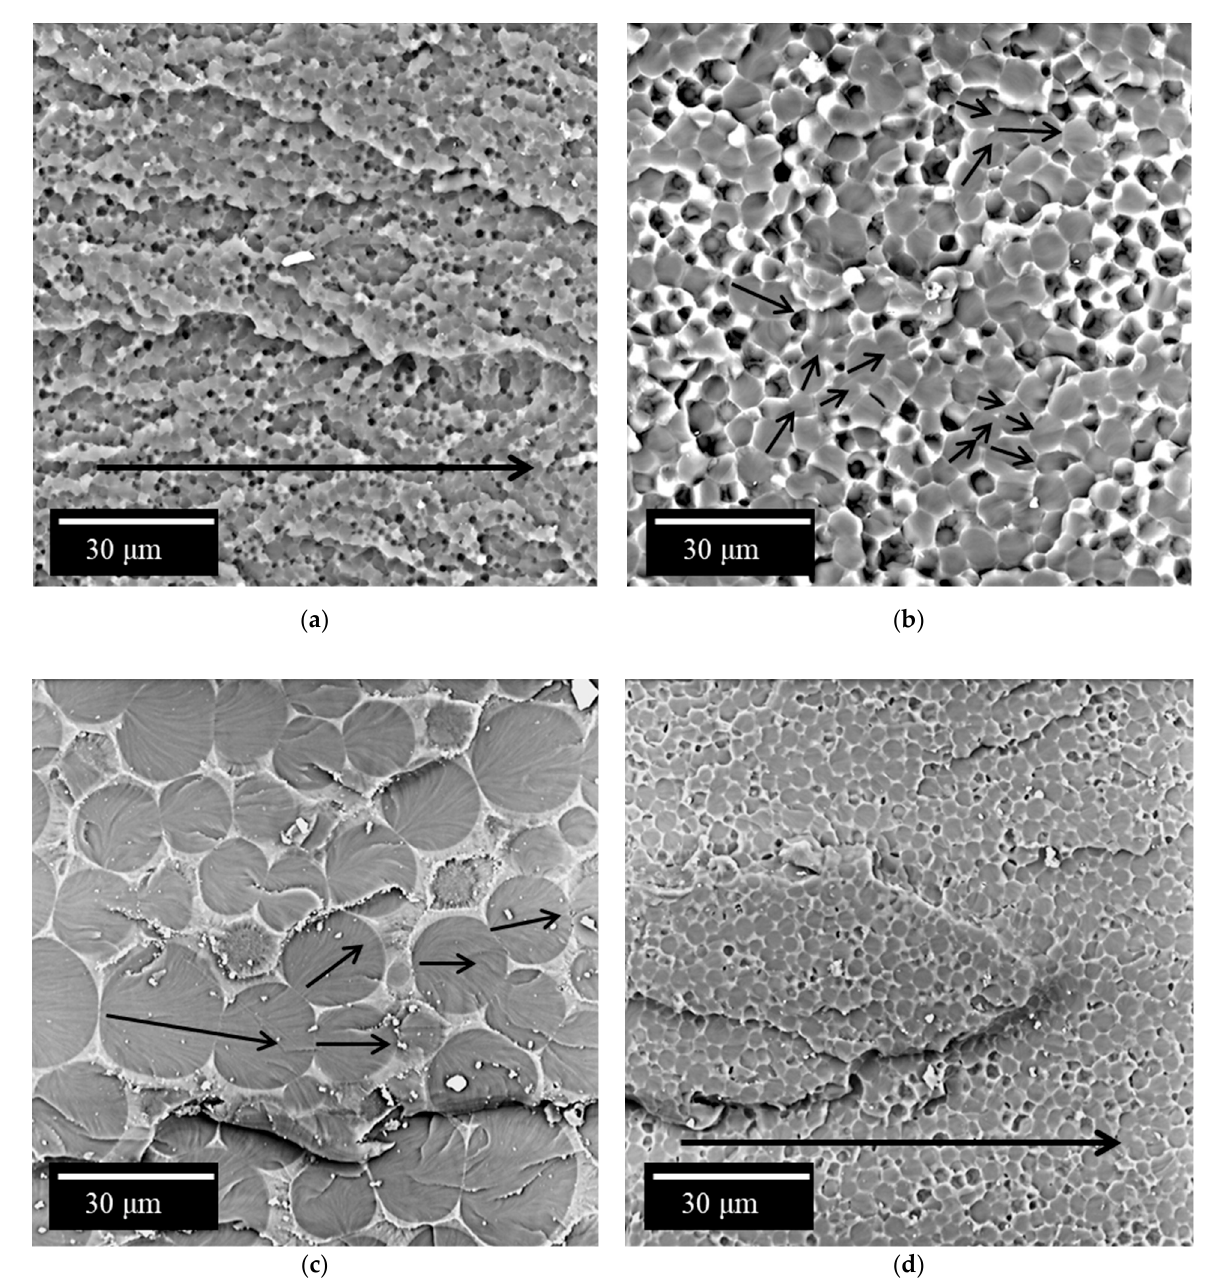
Figure 8. Micrographs of the surface of cracks in the epoxy matrix cured with iso-MTHPA and modified with PSU/FGE (wt. %): ( a ) 20/0; ( b ) 20/10; ( c ) 20/20; ( d ) 30/20.